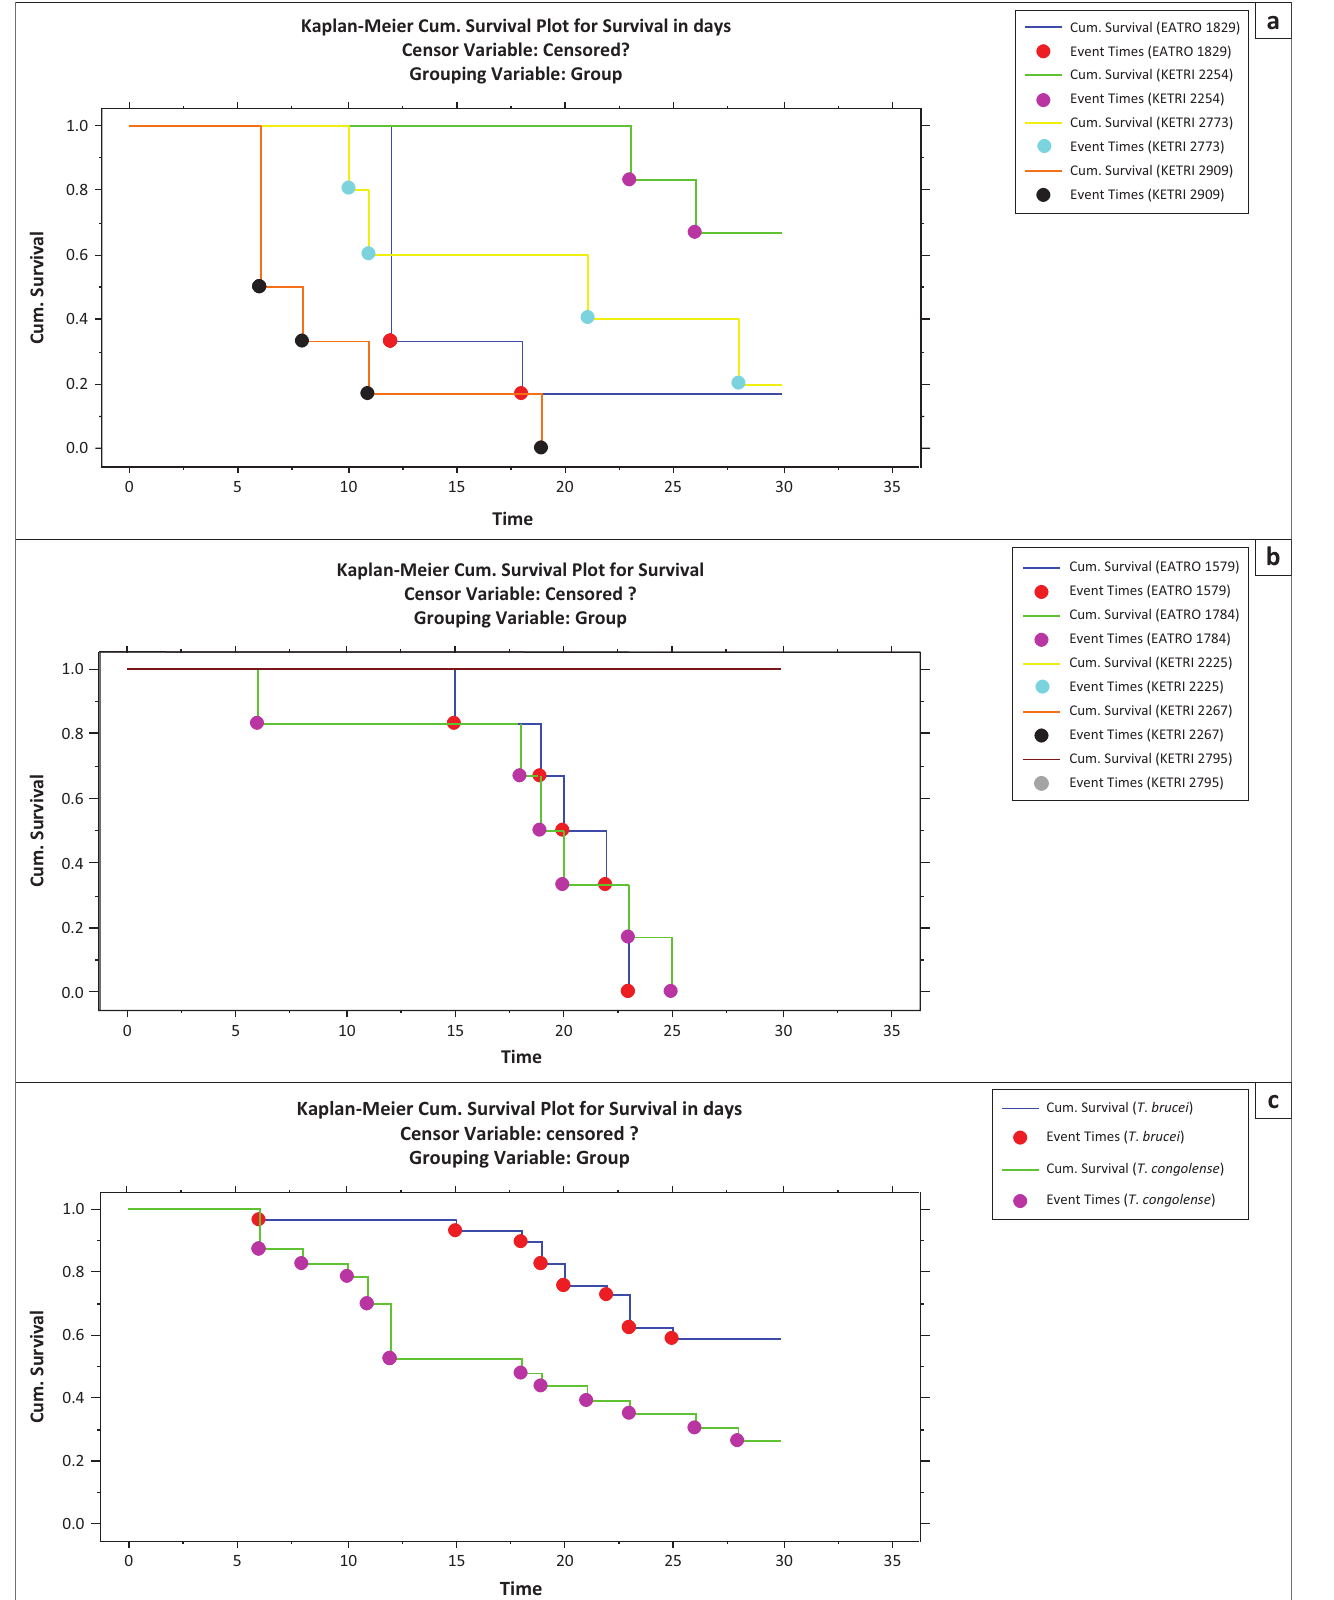
FIGURE 4: Survival distribution functions of mice infected with various (a) Trypanosoma congolense isolates, (b) Trypanosoma brucei isolates and (c) Trypanosoma brucei and Trypanosoma congolense trypanosome